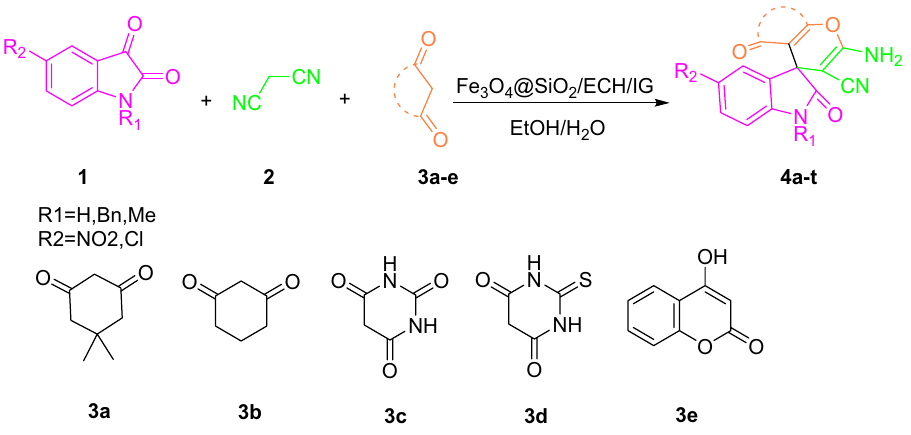
Figure 8. Schematic representation of the Fe 3 O 4 @SiO 2 /ECH/IG and its catalytic activity in the one-pot synthesis of spirooxindole derivatives (4a-t) through multicomponent reaction (MCR) strategy.